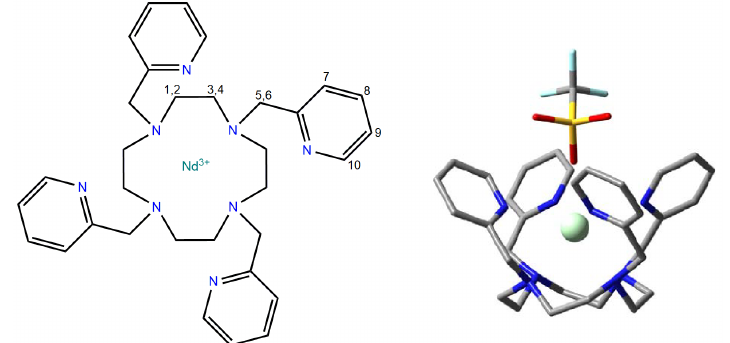
Figure 1. Structure of the cyclen complex [ NdL py ] 3 + . Labels refer to the 10 chemically distinct H atoms, with 1,3,5 representing equatorial CH 2 protons and 2,4,6 representing axial protons. Colours indicate atom type (grey C, blue N, red O, yellow S, light blue F).